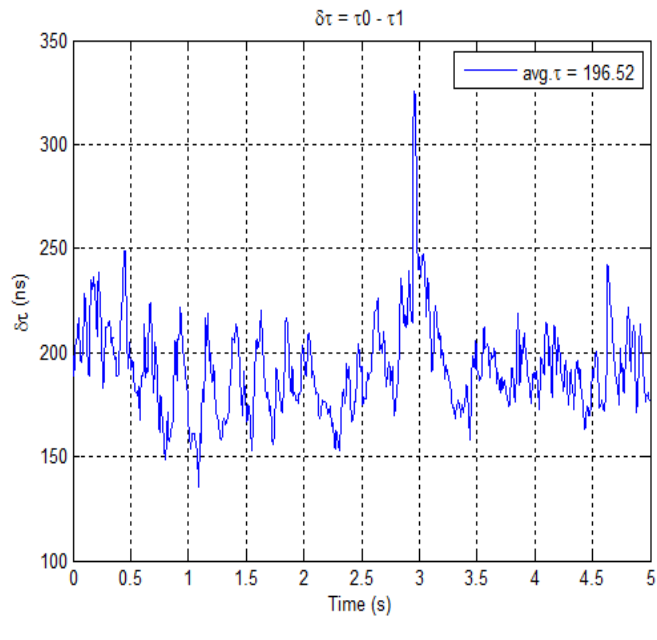
Figure 11. Estimated delay difference between unit 0 and unit 1.